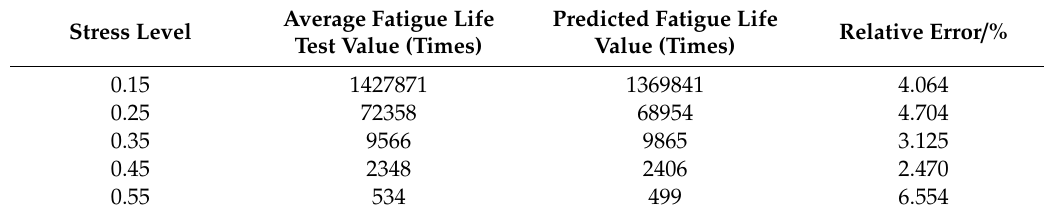
Table 13. Verification results of the fatigue prediction model.